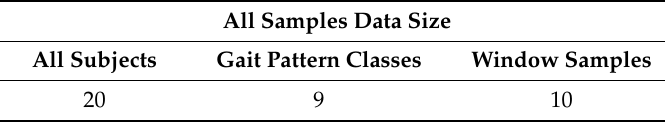
Table 1. In addition, we perform the classification task of nine gait patterns (walk forward, walk left, walk right, go upstairs, go downstairs, run forward, sitting), in order to further evaluate the feasibility of our proposed model for multi-sensor gait telemonitoring applications. Table 1. The total amount of available sample